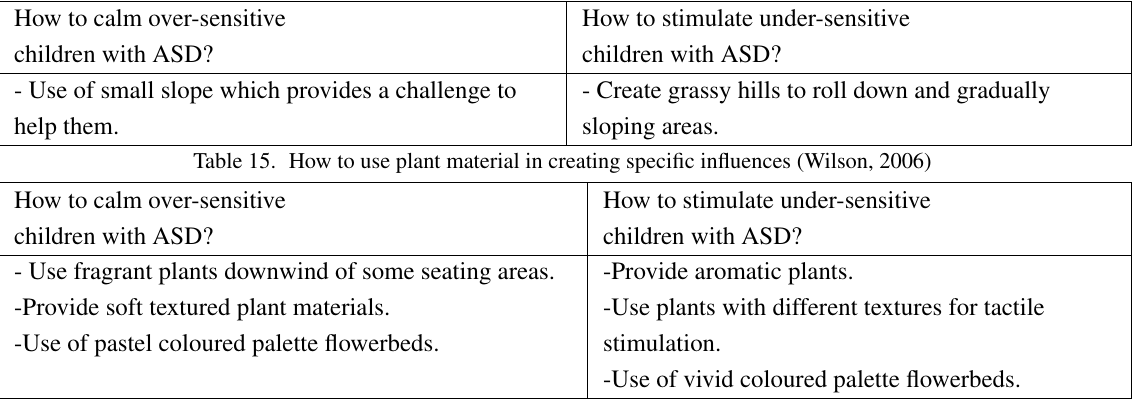
Table 14. How to use landform in creating specific influences (Wilson, 2006)